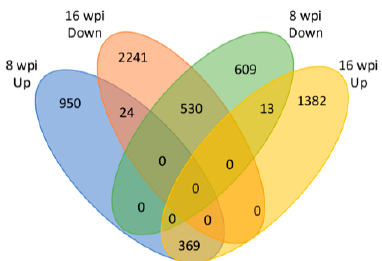
Figure 6. Venn diagram of total number of upregulated and downregulated genes in asymptomatic (8 wpi) or symptomatic (16 wpi) stages of HLB disease.